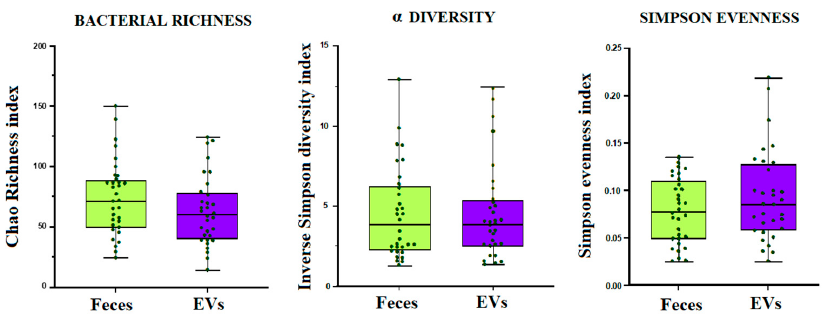
Figure 2. Bacterial diversity for the overall community heterogeneity (Inverse Simpson diversity index), bacterial evenness for the species abundances (Simpson evenness index) and bacterial richness for the total number of species (Chao1 richness index), expressed as a mean value with a standard deviation, for fecal microbiota samples and fecal-microbe-derived EVs when all samples (diarrhea, CD, morbid obesity and controls) were compared together. Statistical differences were calculated according to a non-parametric Wilcoxon matched-pairs signed rank test.